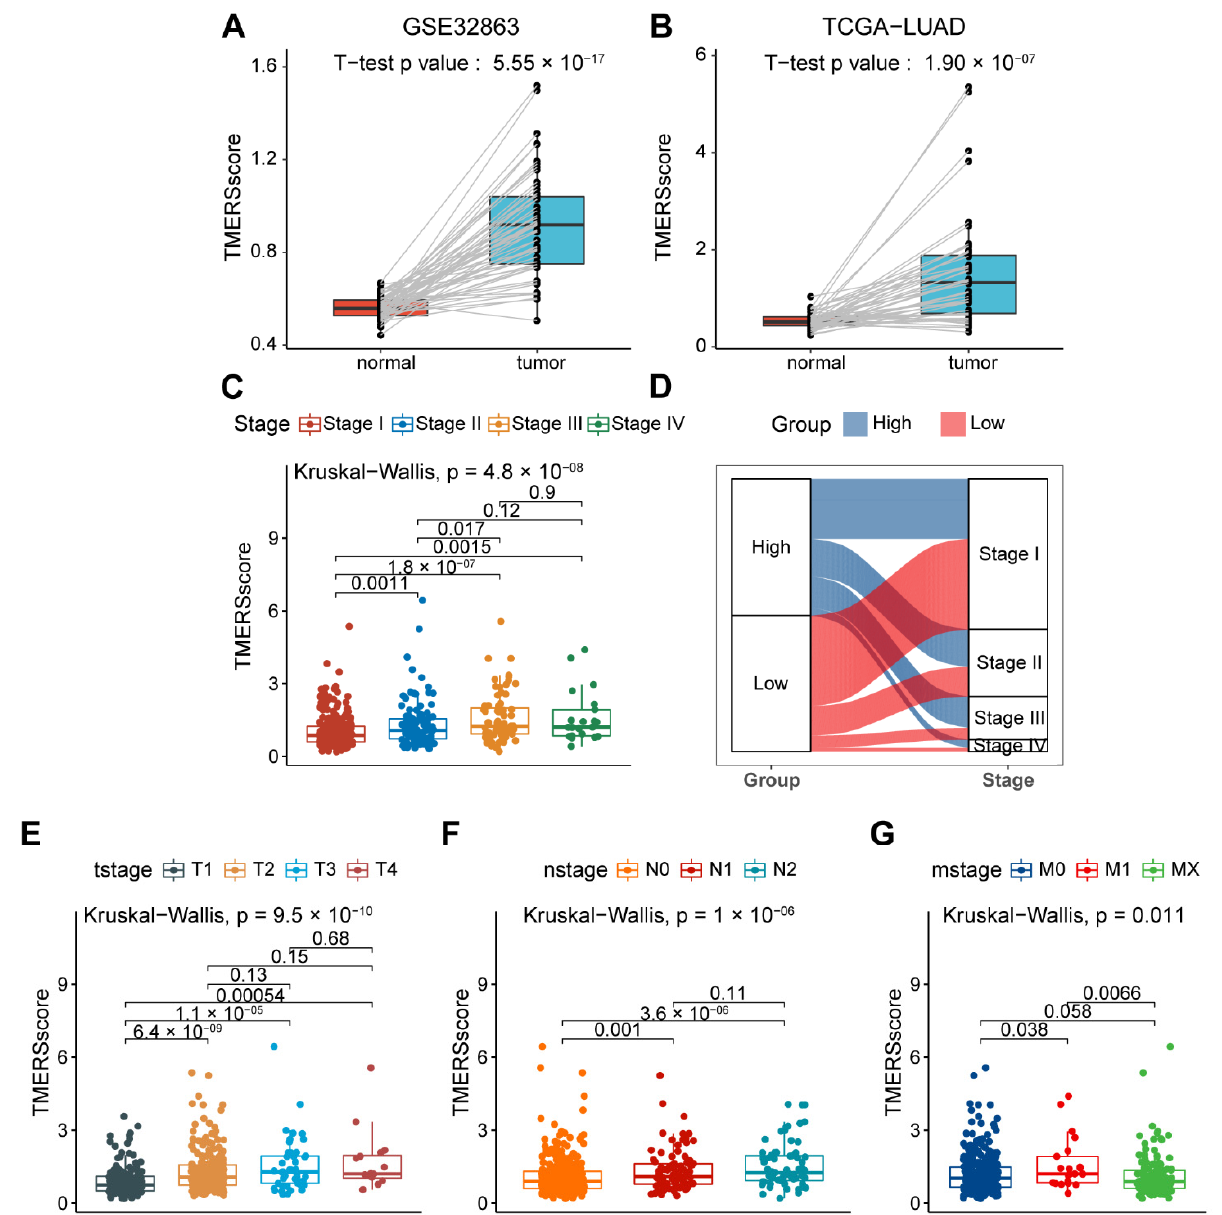
Figure 6. Evaluation of tumor malignancy by TMERSscore. ( A ) Pairwise boxplot of paired normal and tumor samples in the GSE32863 dataset. ( B ) Pairwise boxplot of paired normal and tumor samples in the TCGA cohort. ( C , E – G ) Boxplots showing the difference between the TMERSscore at different AJCC pTNM Stage, T stage, N stage, and M stage, respectively. ( D ) Sankey diagram showing the relationship between high and low TMERSscore subgroups and AJCC Stages.